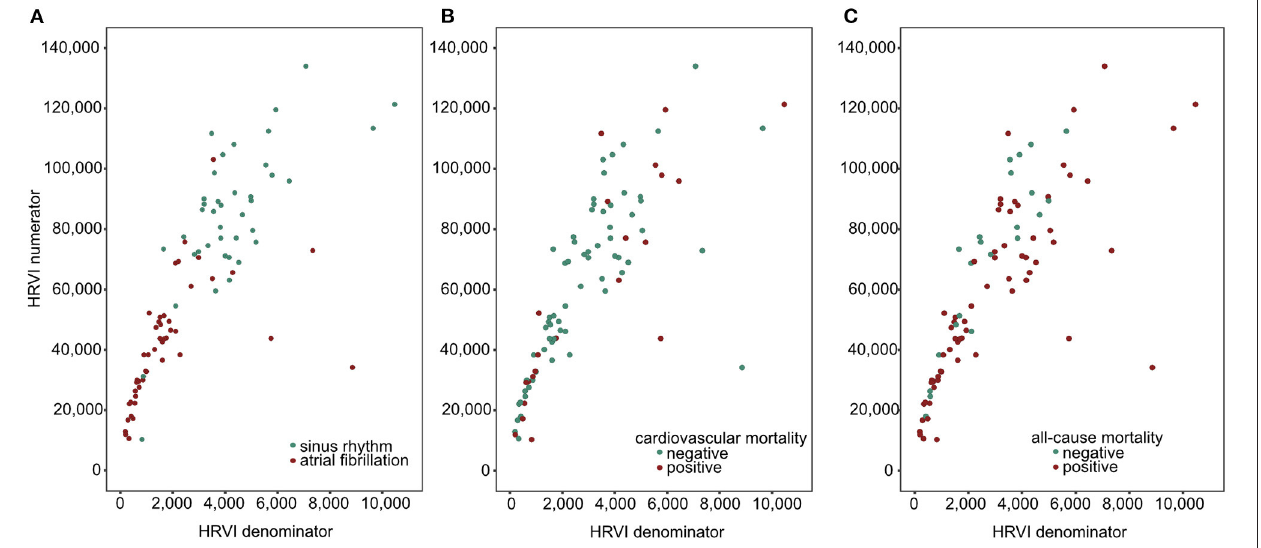
FIGURE 6 | Scatter plots of HRVI numerator and denominator coded for atrial fibrillation or sinus rhythm (A) , cardiovascular (B) , and all-cause mortality (C) . HRVI, heart rate variability triangular index.